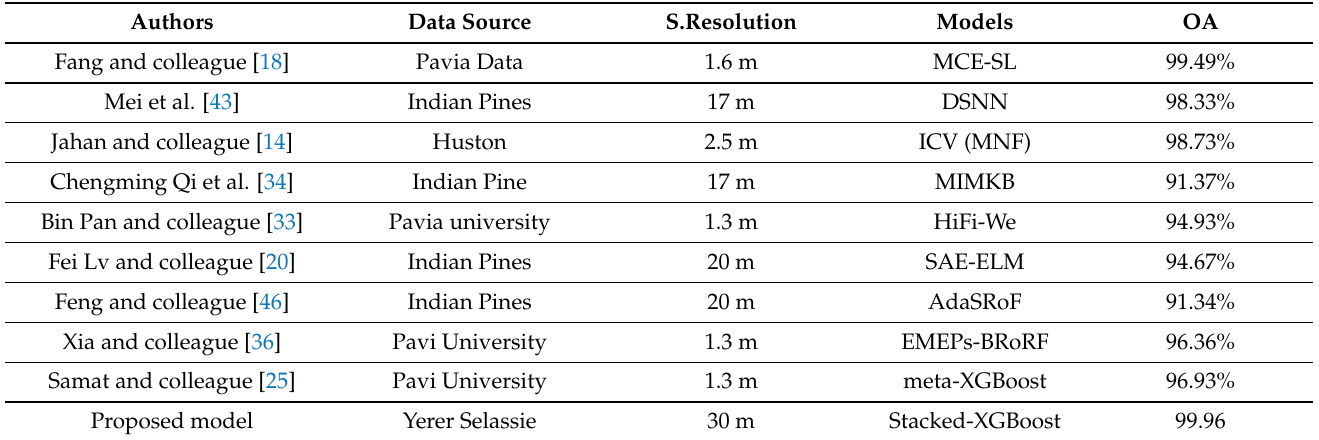
Table 7. Summary of performance by ensemble learning